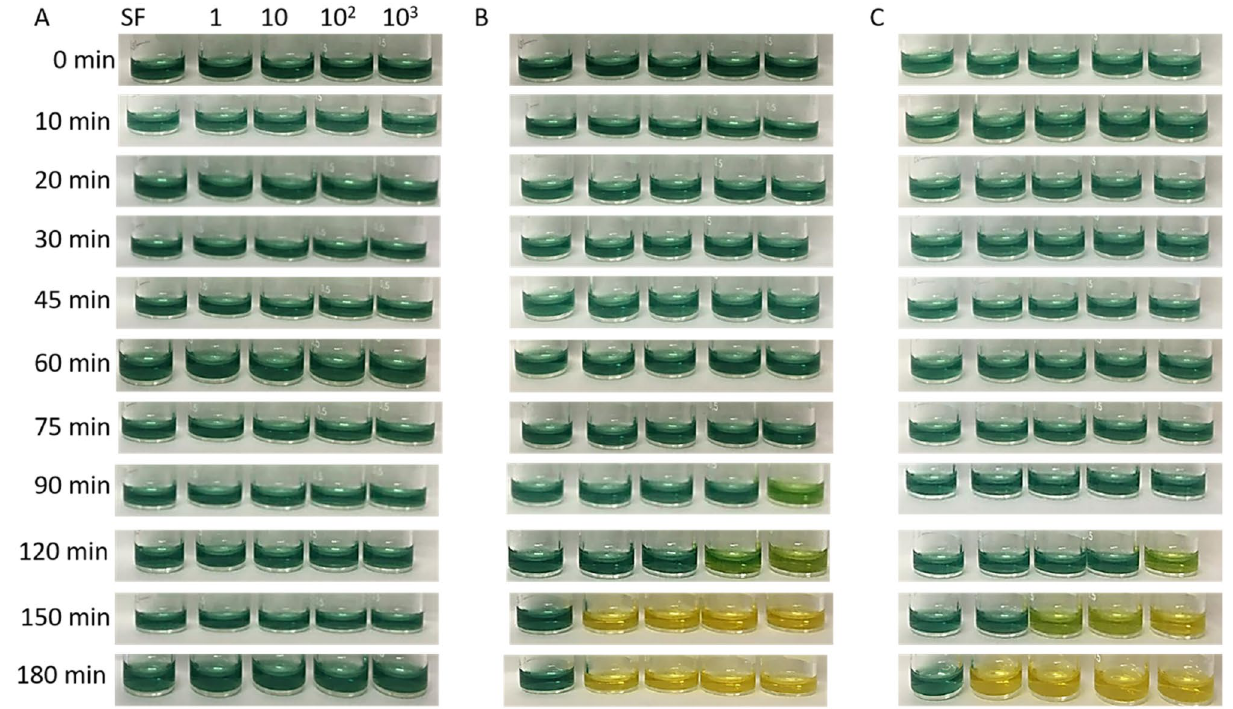
Figure 4. Colorimetric readouts of test 3 with a naked eye for ( A ) E. coli, ( B ) K. pneumoniae and ( C ) P. mirabilis